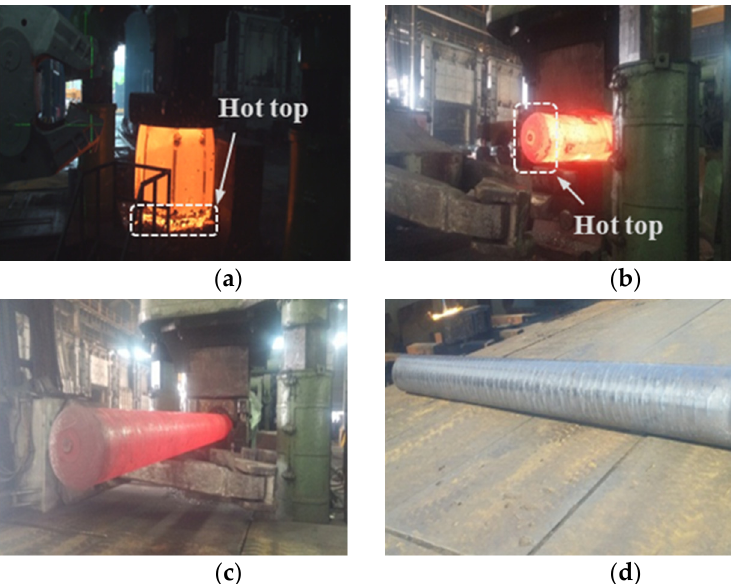
Figure 10. Shop floor round bar forging: ( a ) upsetting; ( b ) bar cogging; ( c ) round bar forging; ( d ) forged bar.